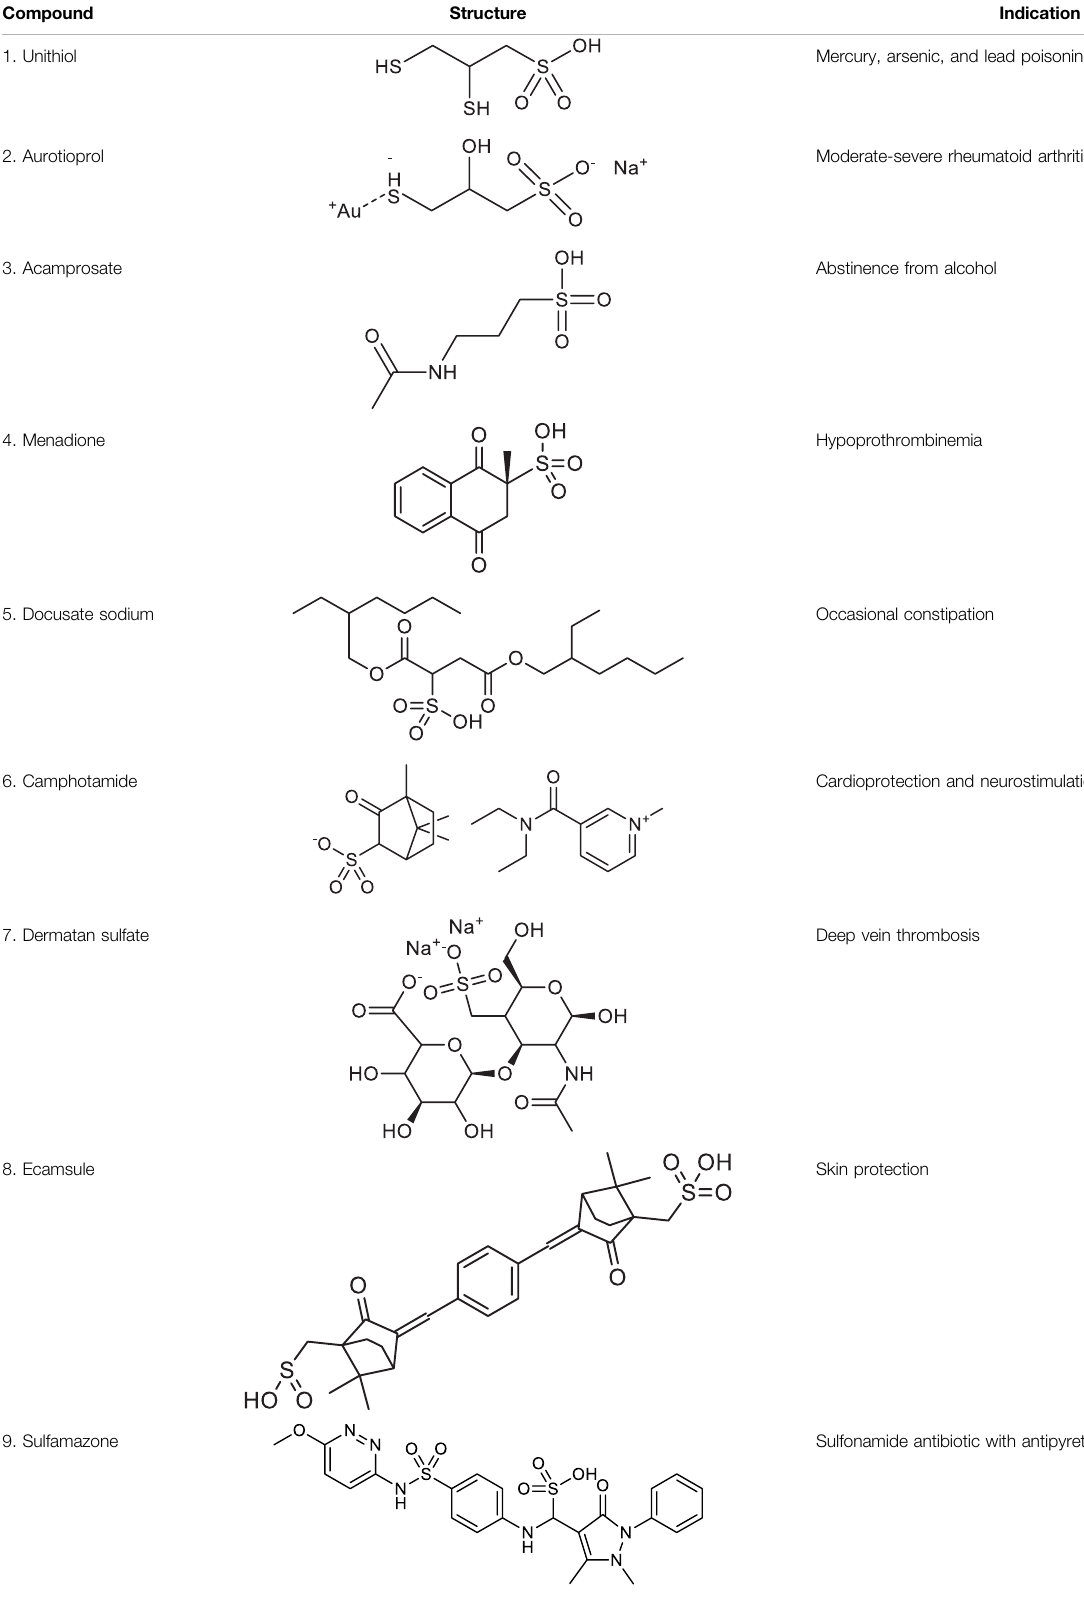
TABLE 1 | Chemical structures and clinical indications of FDA and EMA-approved drugs ( n (cid:1) 13) containing propanesulfonic scaffold of TRA.